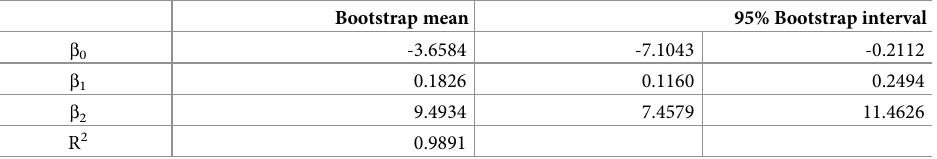
Table 3. Parameter estimation based on the wild bootstrap